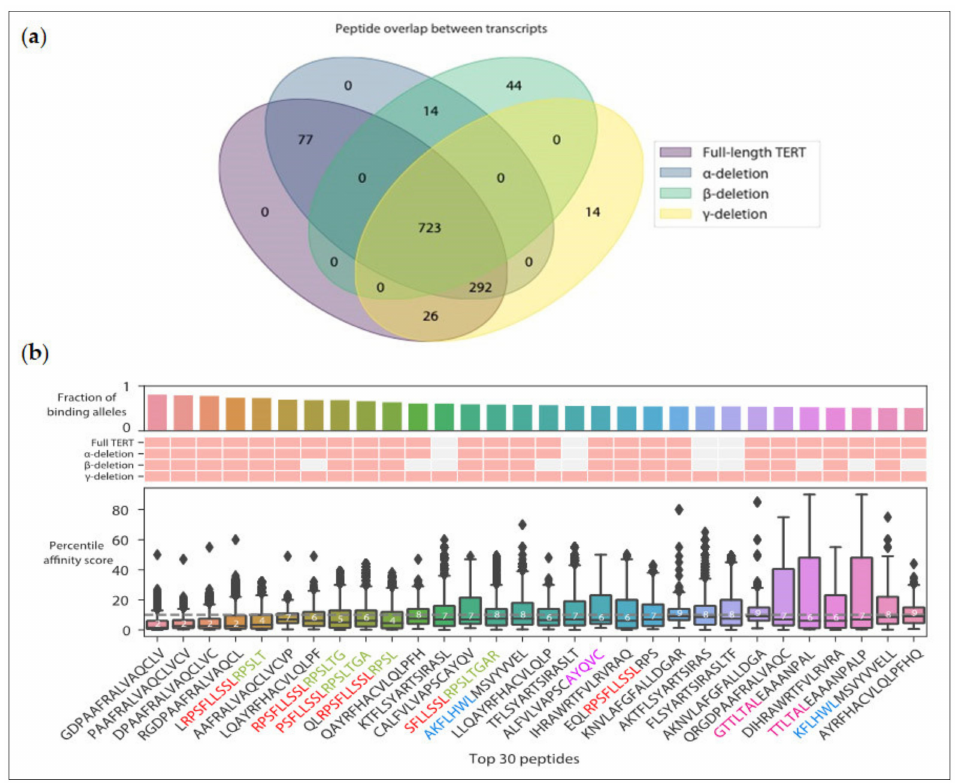
Figure 4. Prediction of the top 30 promiscuous TERT peptides. Predicted a ffi nity scores of 15mer TERT peptides across 1911 molecules containing common MHC-II alleles ( > 10% expression, see Figure 3) were obtained using NetMHCIIpan3.2. ( a ) Venn diagram showing the overlap of unique 15mers originating from 4 TERT transcripts (full length, minus- α , minus- β , and minus- γ TERT transcripts). ( b ) Top 30 predicted promiscuous TERT MHC-II peptides are shown. Peptides with an a ffi nity score < 10 are considered binders [148]. (Top) Barplot indicating the fraction of common MHC-II alleles that can be bound to each peptide. (Middle) Heatmap with red boxes indicating each peptide’s transcript of origin. (Bottom) Boxplots denoting the distribution of a ffi nity scores for all unique 15mer peptides from each TERT transcript studied. Known MHC-I binding motifs are highlighted and identified using di ff erent colors (red, green, blue, and purple) in respective 15mer sequences: R342 (red), R351 (green), I540 (blue), A167 (purple), L1107